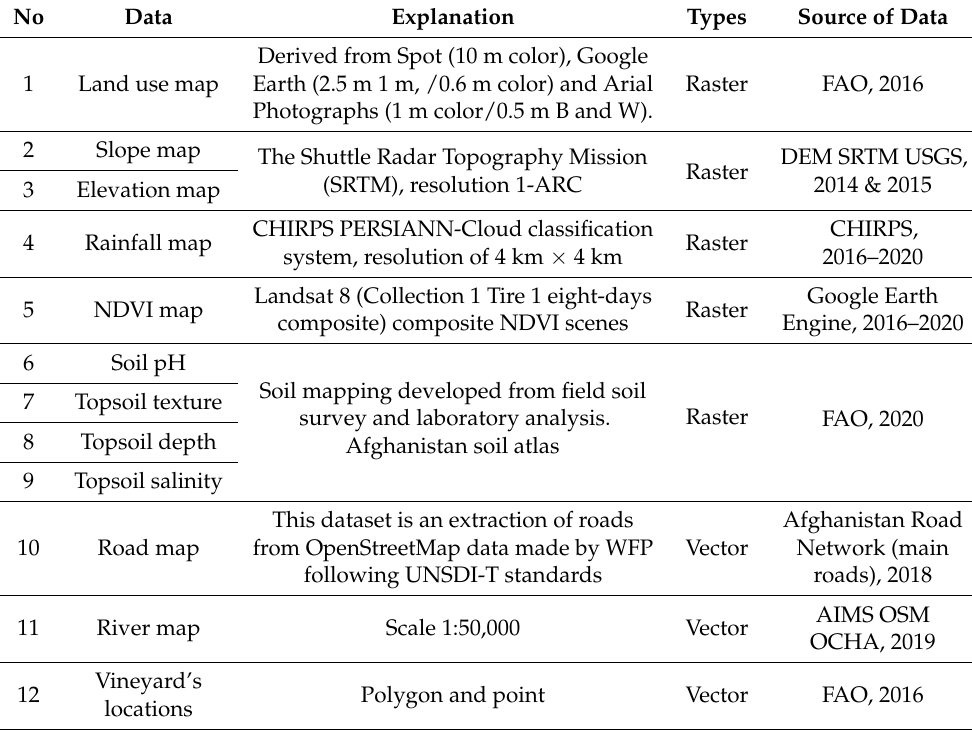
Table 1. Variable selections and their explanation for specifications that included data types and sources.